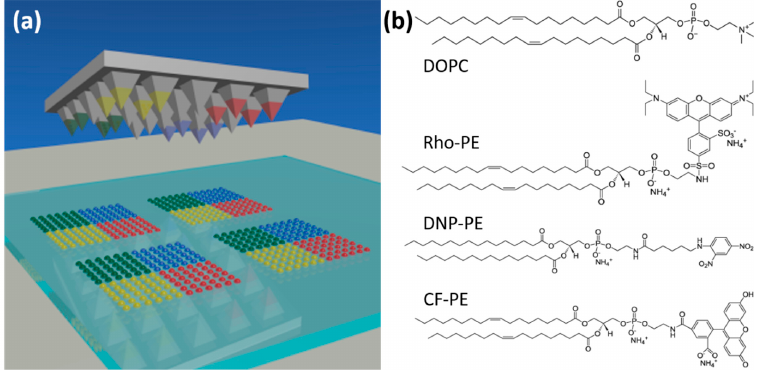
Figure 1. Scheme of polymer pen lithography (PPL) and the phospholipids used in the present study. ( a ) A polymer stamp featuring pyramidal pens is inked with di ff erent phospholipids in distinct segments and then used for printing of multiplexed lipid arrays. ( b ) The chemical structure and abbreviated names for the di ff erent phospholipids used in the printing